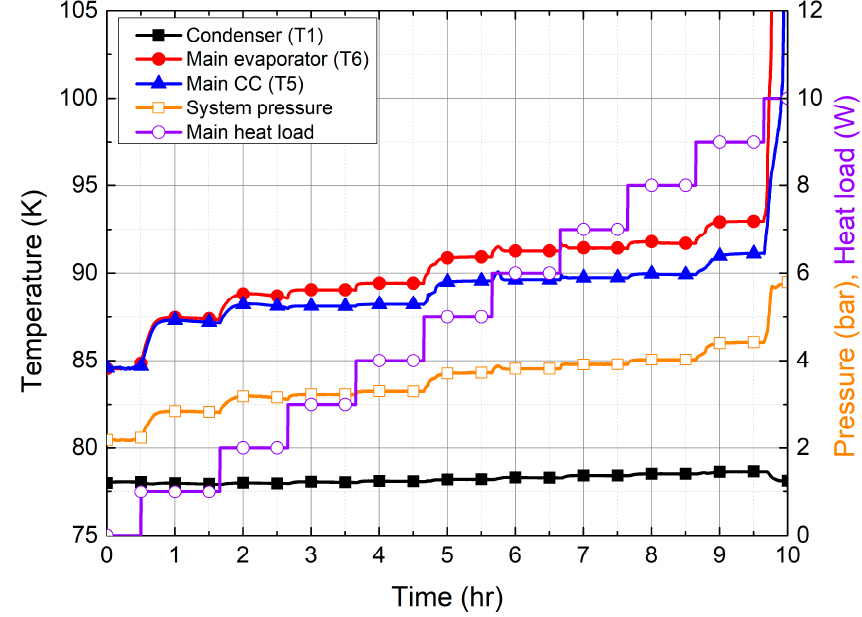
Figure 10. Temperature change over time as heat load was applied to the main evaporator and circulated through the main loop.